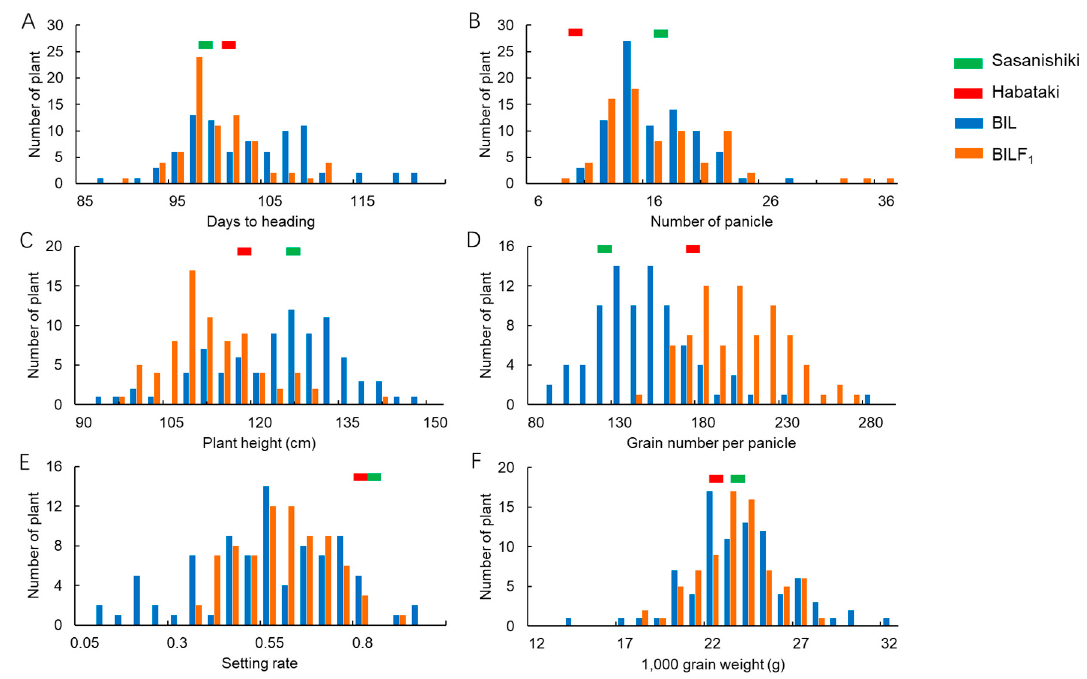
Figure 3. The distribution of yield-related traits in BILs and BILs. ( A – F ) The distribution of days to heading, number of panicles, plant height, grain number per panicle, setting rate, and 1000-grain weight in BILs and BILF 1 s.